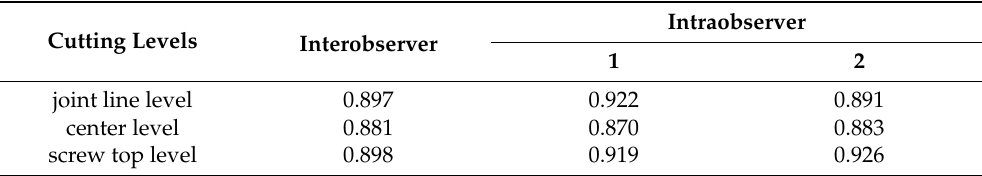
Table 2. ICC of inter-observer and intra-observer errors in tibial tunnel diameter measurements of different levels.